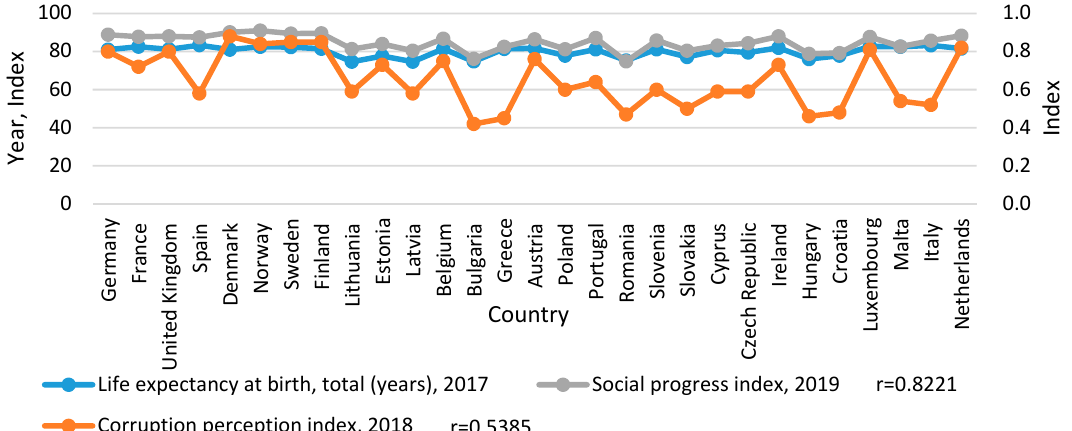
Figure 6. Correlation between the life expectancy at birth, 2017, and corruption perception index , 2018, and social progress index, 2019, of the 25 EU countries, the UK and Norway under evaluation. Research shows the existence of a strong dependency between the 2018 population distribution by the income group, type of household and tenure status, the 2019 social progress index ( r = − 0.7633, inverse dependence) and the 2018 human development index ( r = − 0.7125, inverse dependence). There are average dependences between the 2018 population distribution by the income group, type of household and tenure status and the 2018 gender inequality index ( r = 0.6743, linear dependence) (Figure 7), the 2018 corruption perception index ( r = − 0.6794, inverse dependence) (Figure 7), the 2018 labour productivity ( r = − 0,5096, inverse dependence), the 2020 quality of life (except Luxembourg) ( r = − 0,6008, inverse dependence) (Figure 7) and the 2018 happiness index ( r = − 0,5804, inverse dependence) (Figures 7 and 8).